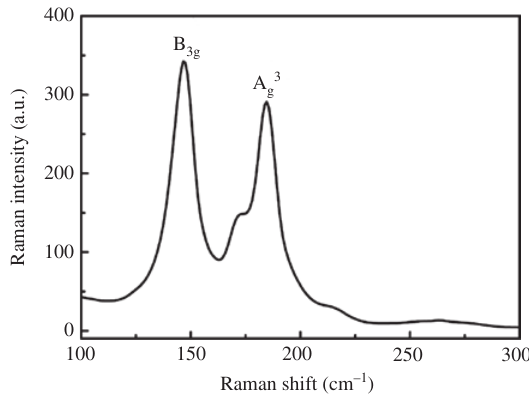
Figure 3: Raman spectrum of GeSe